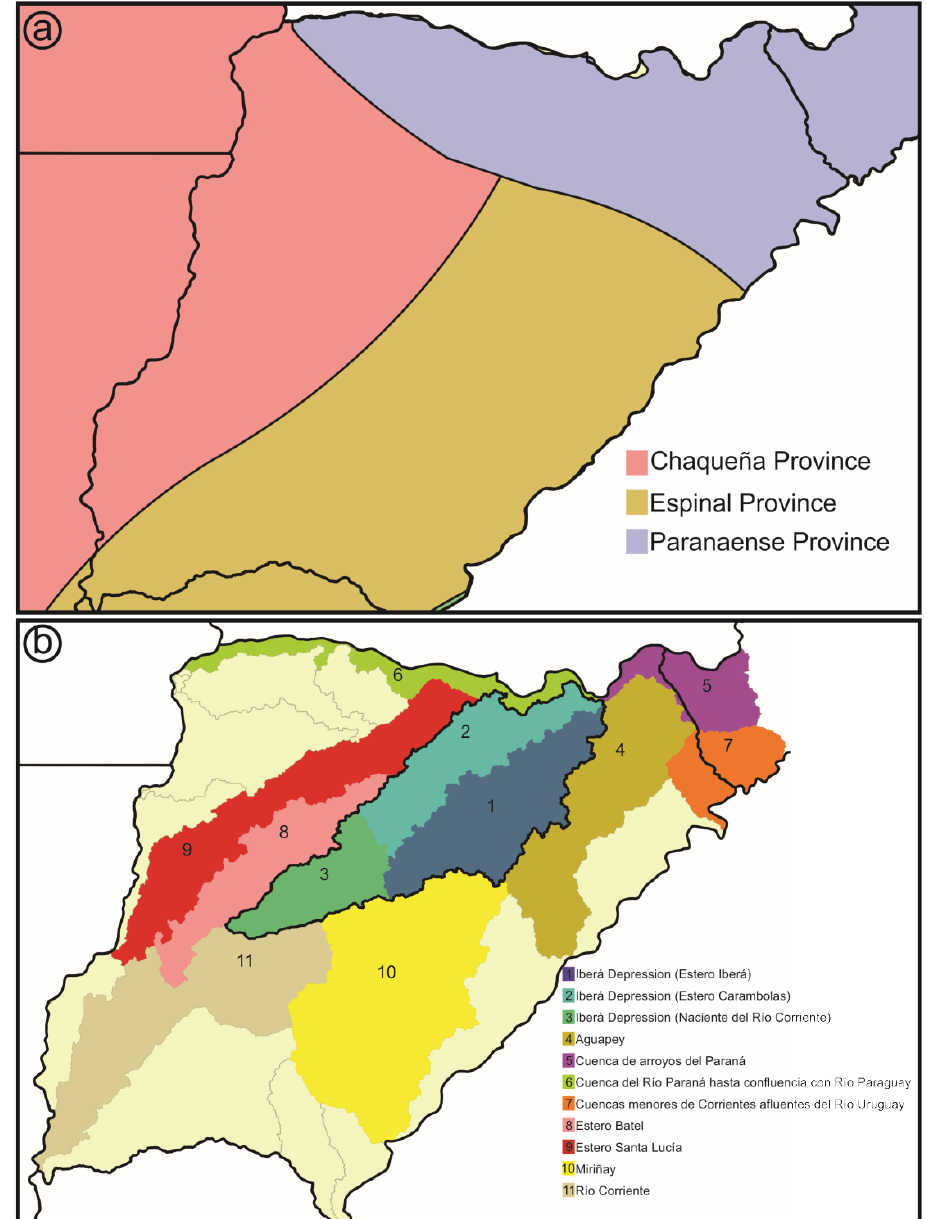
Figure 4. ( a ) Biogeographic provinces sensu Cabrera and Willink [17], ( b ) Map showing the Iberá Depression and surrounding hydrological basins, the selected basins in this study are numbered and highlighted in color.